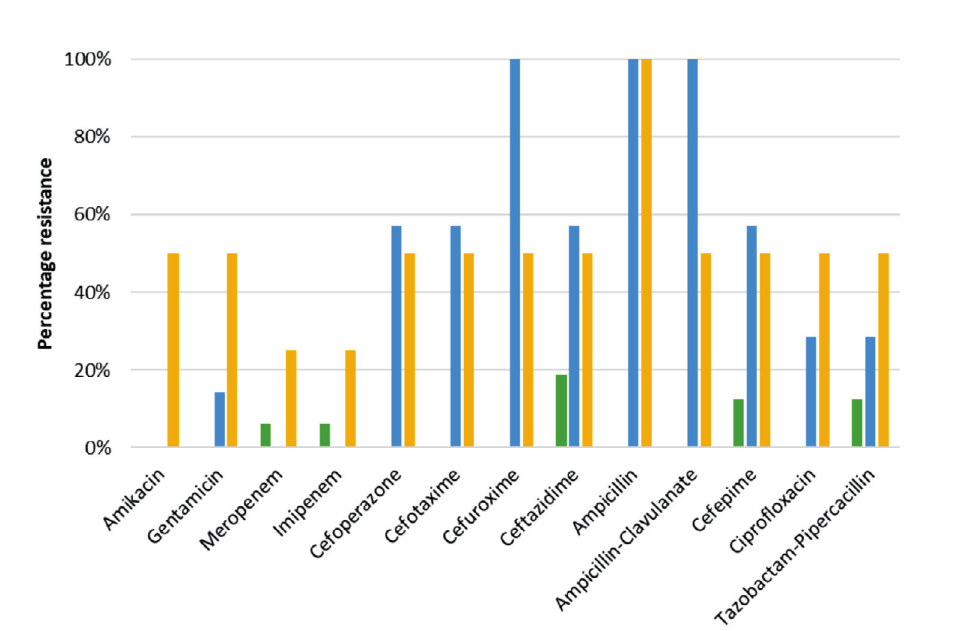
*Susceptibility of Pseudomonas aeruginosa against cefoperazone, cefotaxime, cefuroxime, ampicillin and ampicillin- clavulanate were not Fig. 3: Resistance patterns of the most common Gram-negative bacteria causing orthopaedics SSI.